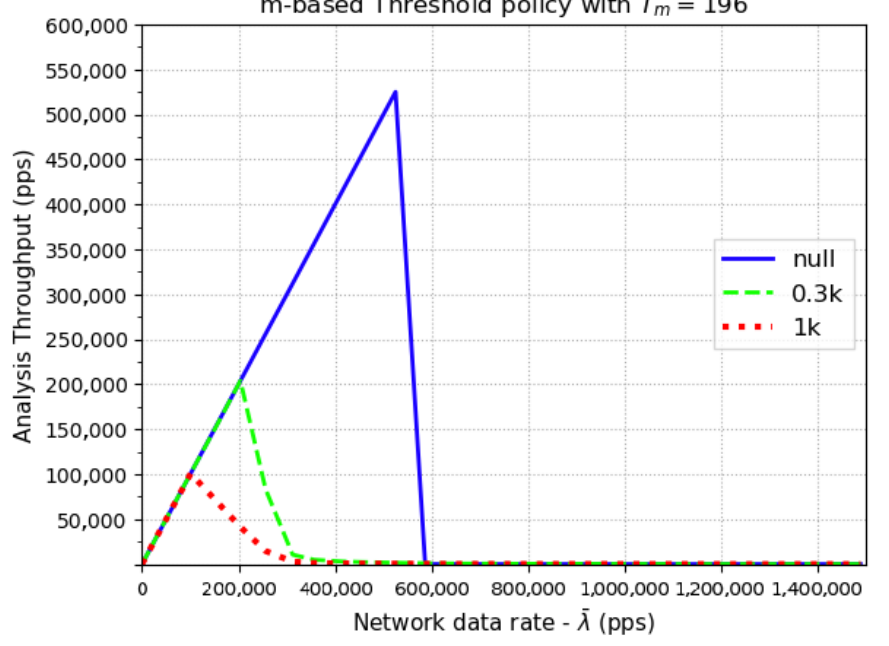
Figure 9. Performance simulation for m-based threshold policy.